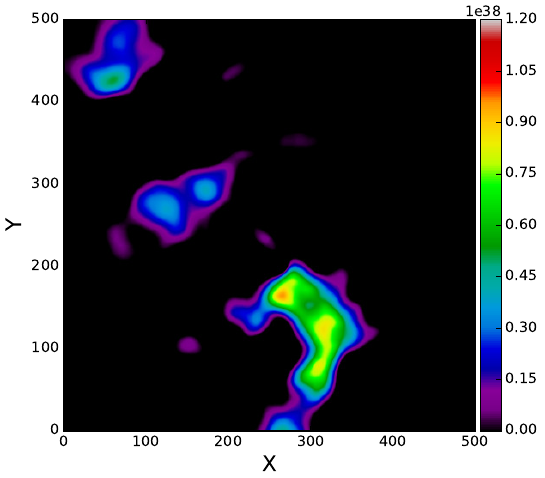
Figure 8. A520 galaxy inclusion. The galaxies explain the regions shown. These regions are offset from the